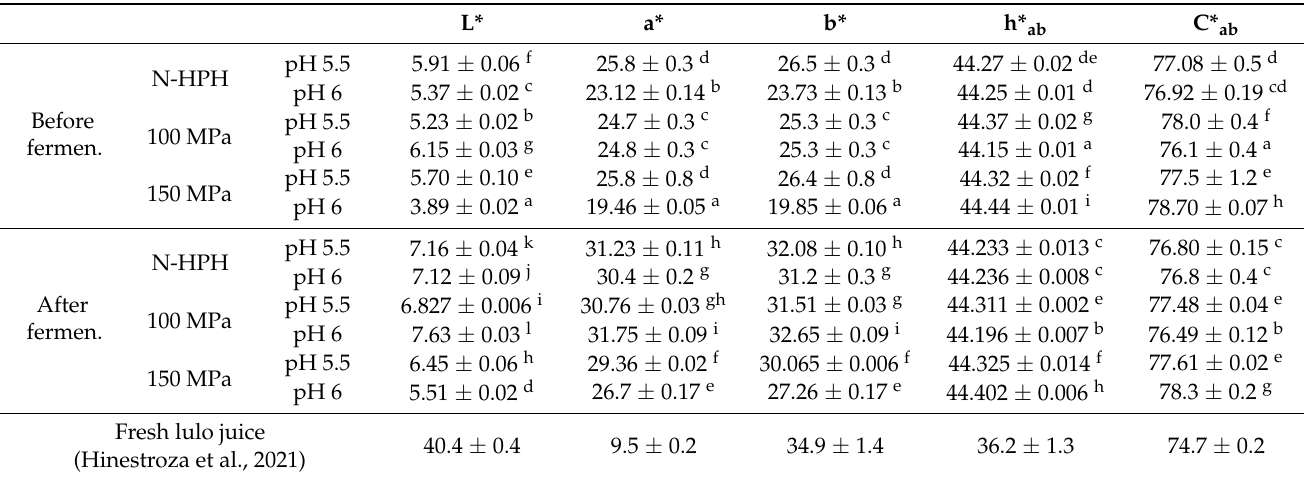
Table 3. CIE-L*a*b*, h* ab and C* ab coordinates of the lulo juices before and after fermentation and as a function of homogenization pressure applied and pH. Mean values ± standard